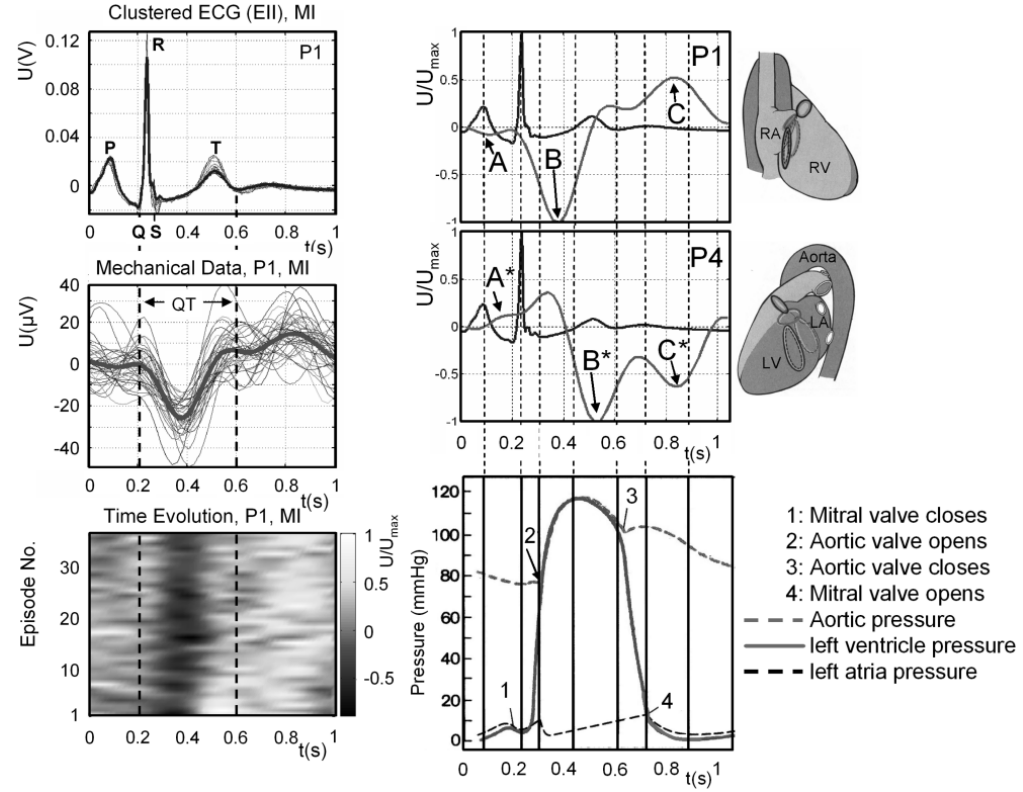
variation of the mechanical data. The lower right time course of Figure9 is a part of a Wiggers diagram comprising the pressure in the left ventricle (bold line), the aortic pressure (dashed bold line), and the pressure in the left atria (thin dashed line). Figure 9. Left: Evolution of the reconstructed surface displacement intervals measured in a breath hold (MI) in the selected positions. Right: Comparison of the normalized time courses reconstructed from two exposure positions (P1, P4) measured during maximal inspiration and corresponding ECG. Wiggers diagram: 1: Mitral valve closes (stops filling of left ventricle), 2: Aortic valve opens (left ventricular volume is ejected), 3: Aortic valve closes, 4: Mitral valve opens (filling of left ventricle). A/A*: contraction of right/left atrium. B/B*: contraction of right/left ventricle. C/C*: filling of right/left ventricle. Anatomical sketch and pressure curve taken and adapted from